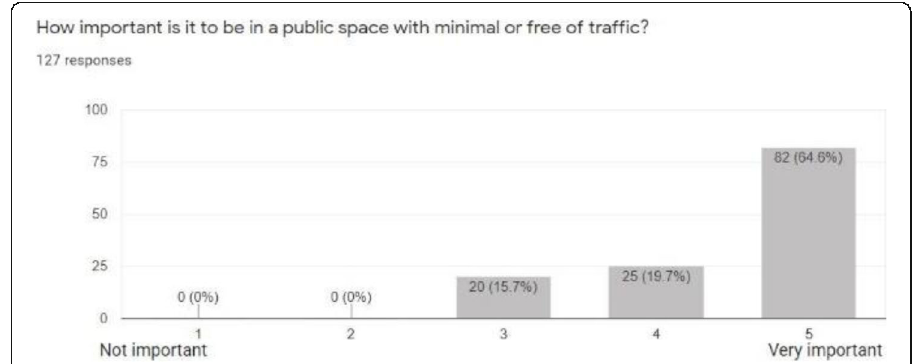
Fig. 17 Importance of protection from traffic (Author)